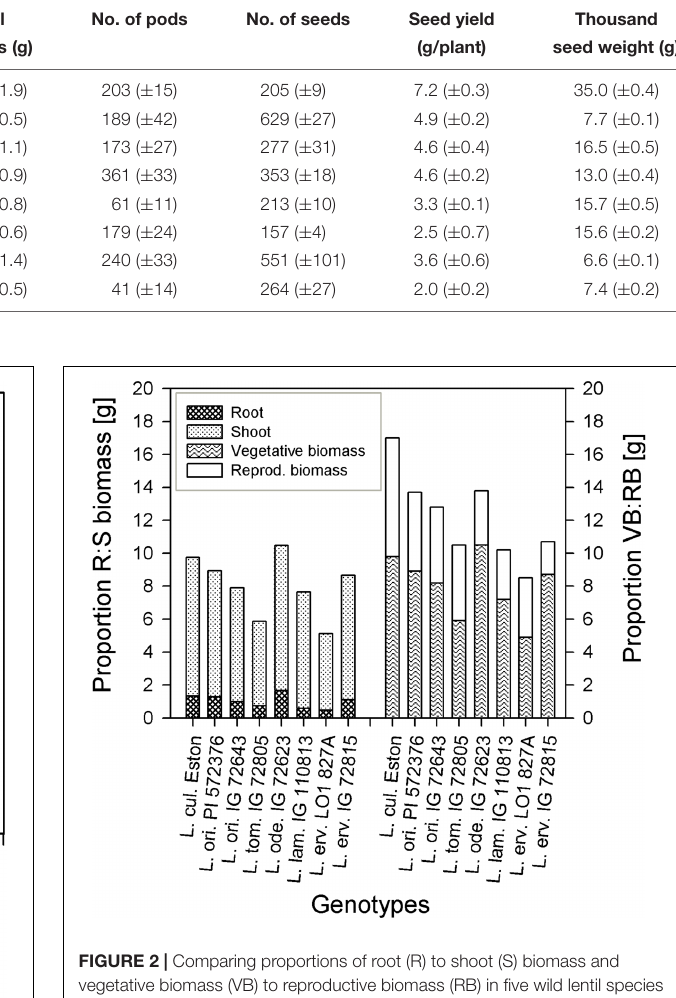
TABLE 1 | Comparison of above ground phenotypic traits for Lens culinaris Eston and five wild lentil species grown under fully watered conditions (mean ± SE).